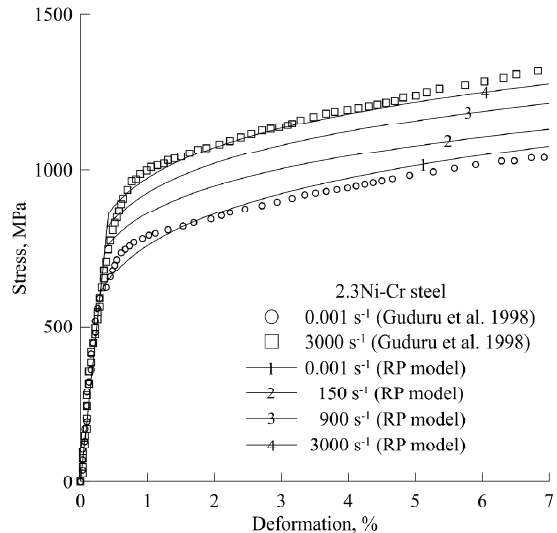
Fig. 4. Stress-strain dependences of 2.3Ni-Cr steel (data from [54]) on strain rates 0.001 s –1 and 2650 s –1 , predicted by relaxation model ( E =205 GPa, =610 MPa;  =20,  =70  s,  =0.18).  y